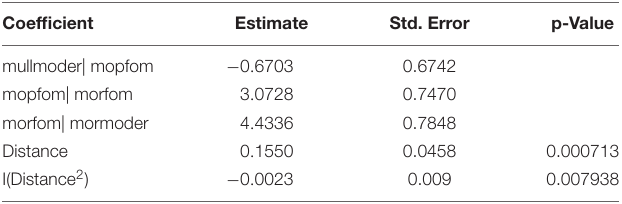
TABLE 3 | Results of the ordered categorical logistic regression for estimating the relative proportions of the four humus forms as a function of the distance to the beech group.